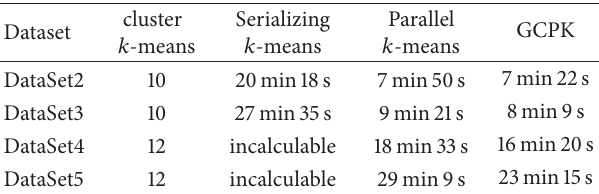
Table 2: Clustering